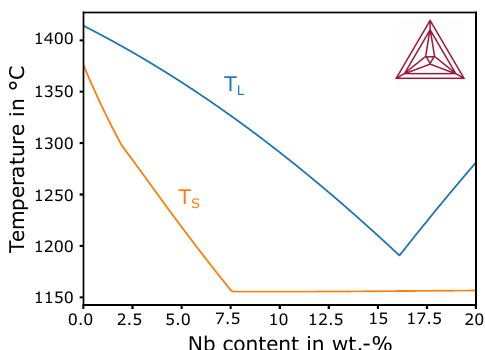
Figure 6. Quasibinary phase diagram of IN718-Nb calculated with ThermoCalc (2017b, TTNI8 database) up to 20wt-% Nb content. Liquidus ( T L ) and solidus ( T S ) curves are shown.